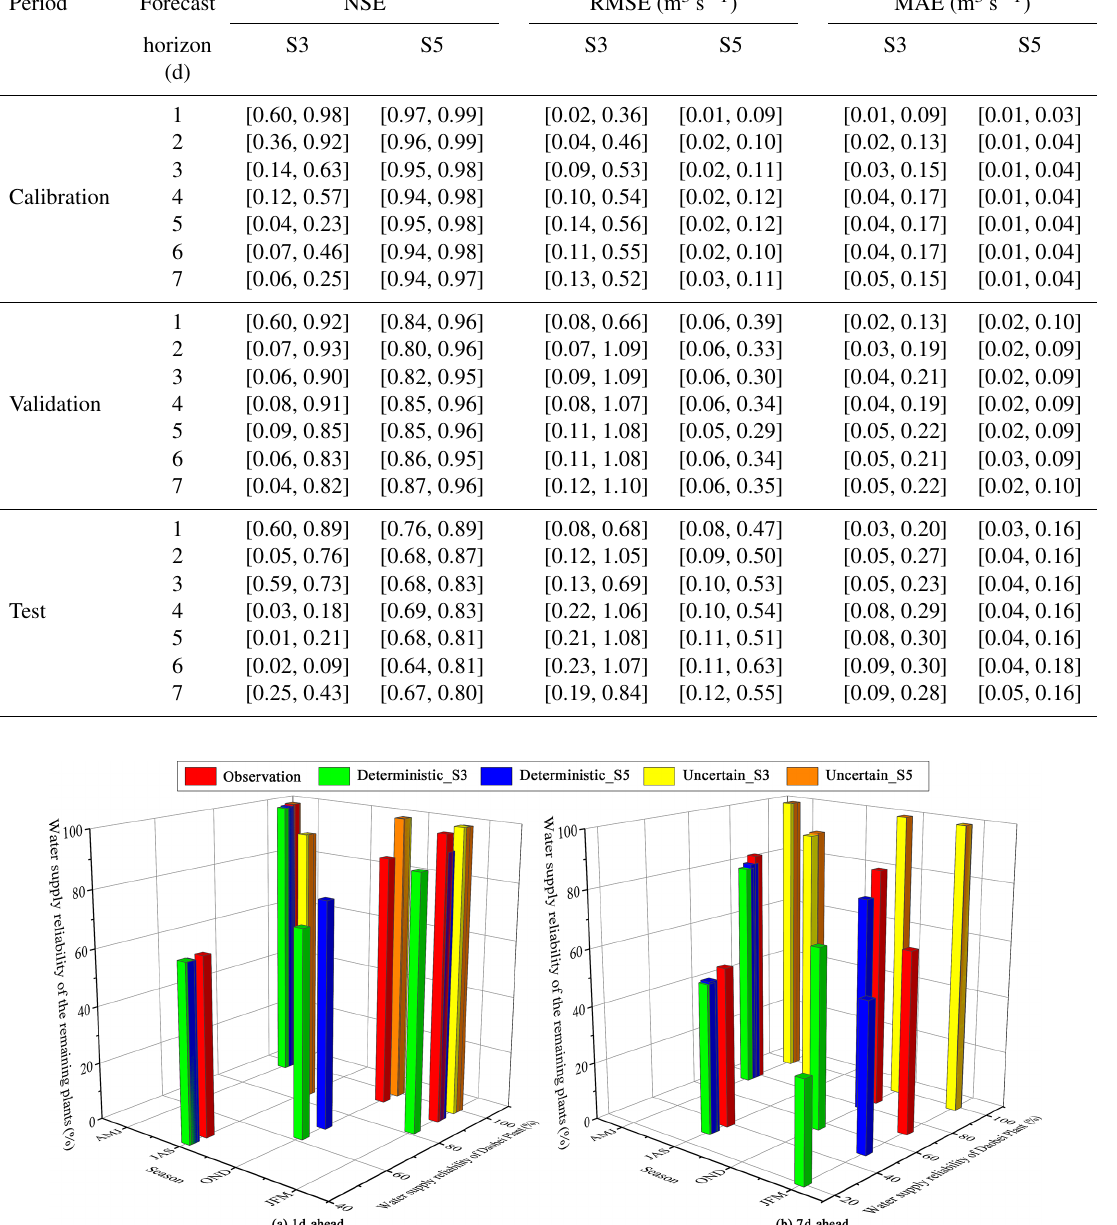
Figure 15. Seasonal system performance of water supply